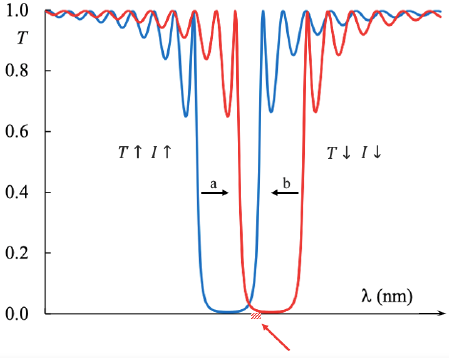
Figure 5. The transmission spectrum at j = 1 undergoing alternate redshift (a) and blueshift (b) following the change of intensity of the light beam due to the consequent change in transmission for the range of wavelengths indicated by the red arrow (see text).